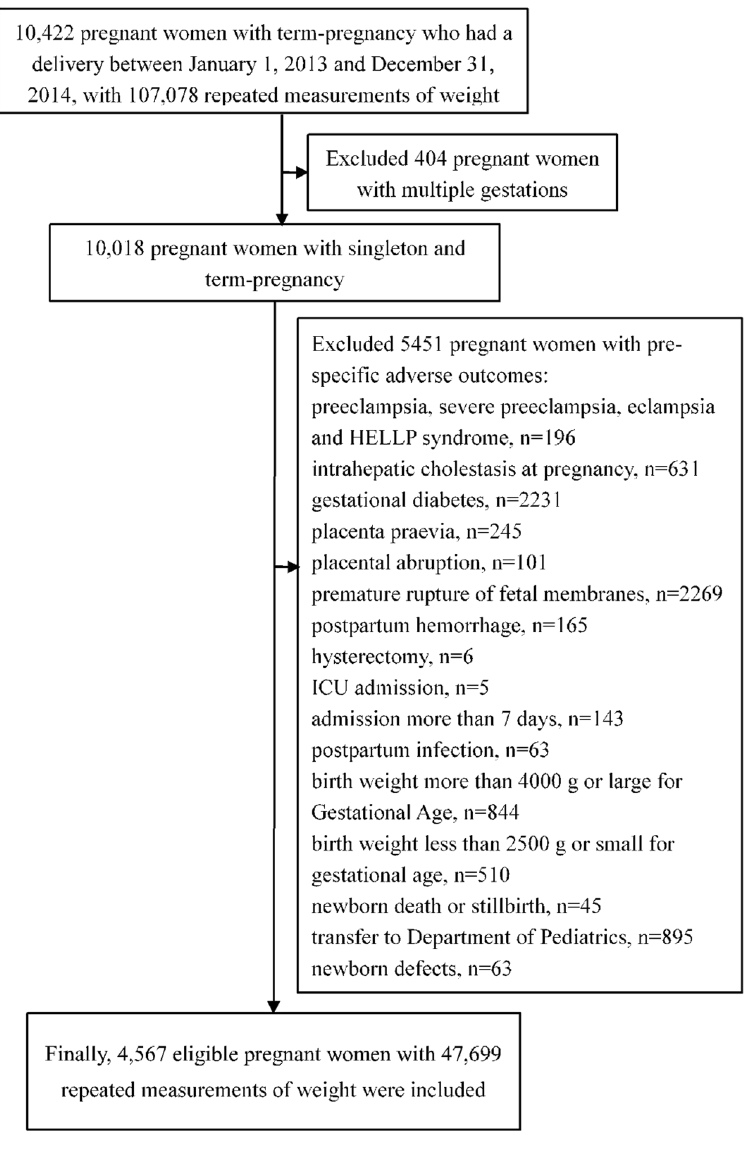
Figure 1. The flow chart of included